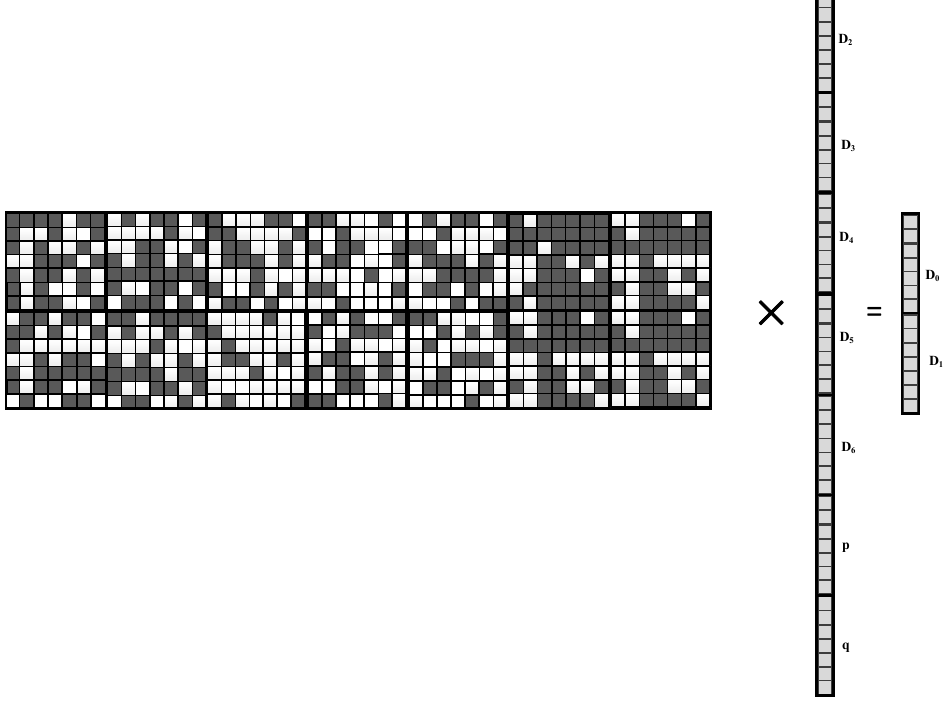
Figure 6. The decoding in the N-Schedule scheme. The XOR operation number is equal to the number of ones minus one. The number of ones is 316 in 14 rows of the decoding matrix; hence, the number of XOR operations is 316 minus 14 which is equal to 302. Now, let us compare the number of ones in the first line with the number in the eighth line to calculate D 1,0 and D 2,0 , respectively. The number of ones is 30 in the first line, while it is 25 in the eighth line, which means the number is the sum of 29 and 24. We can calculate one of the two lines from the XOR operation; then, the other line can be obtained from the first line using the erasure code method. We can formulate the equation shown as Equation